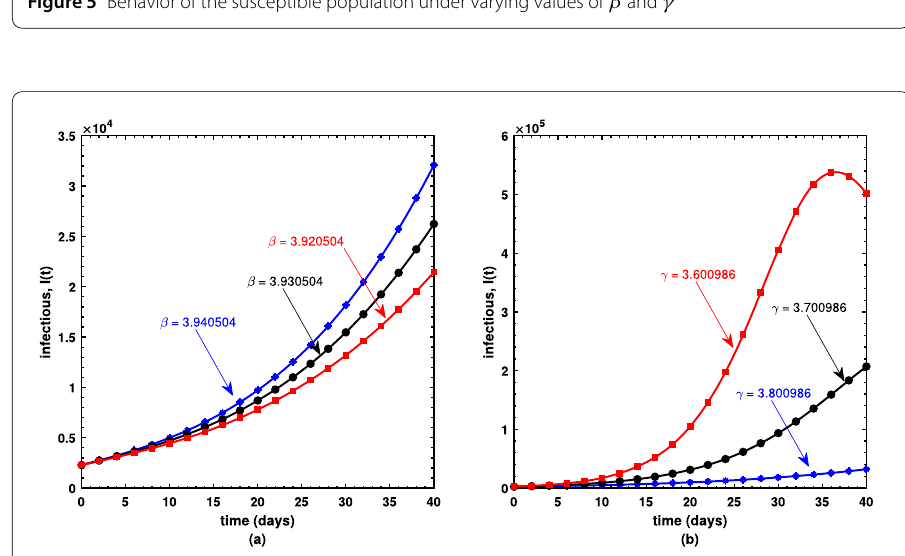
Figure 5 Behavior of the susceptible population under varying values of β and